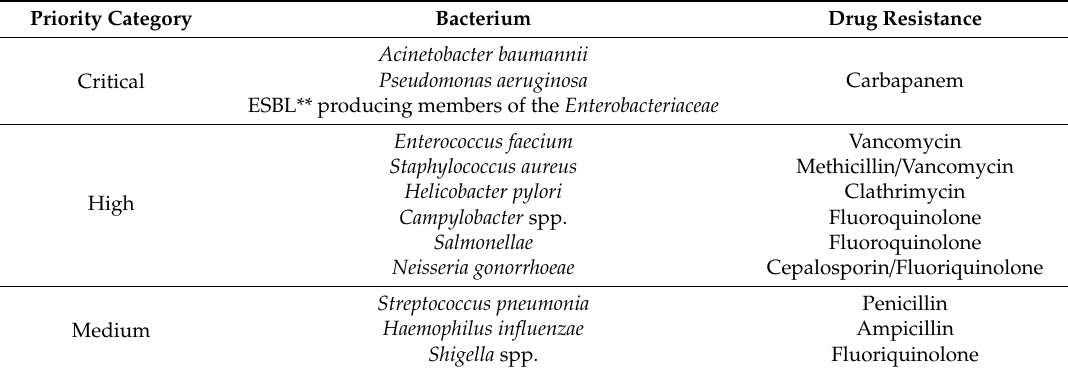
Table 3. The WHO Dirty Dozen Pathogen List of Problematic Super Bugs